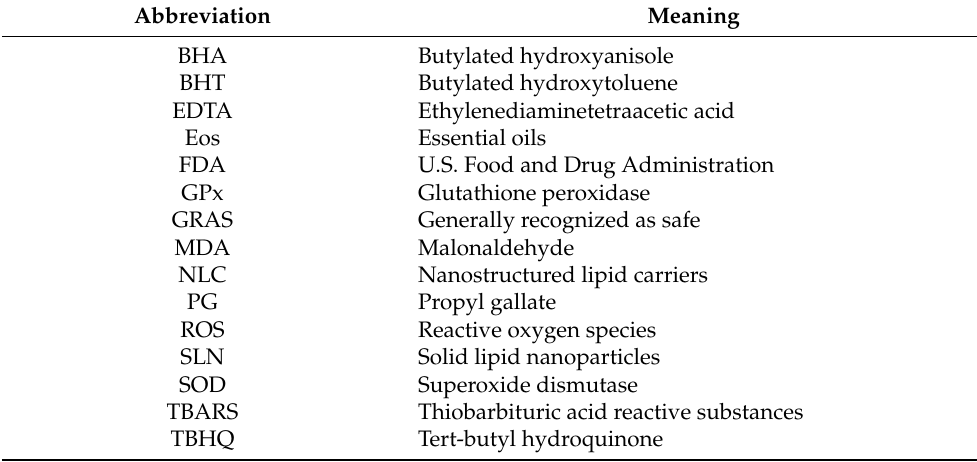
Table 1. List of abbreviation used in the